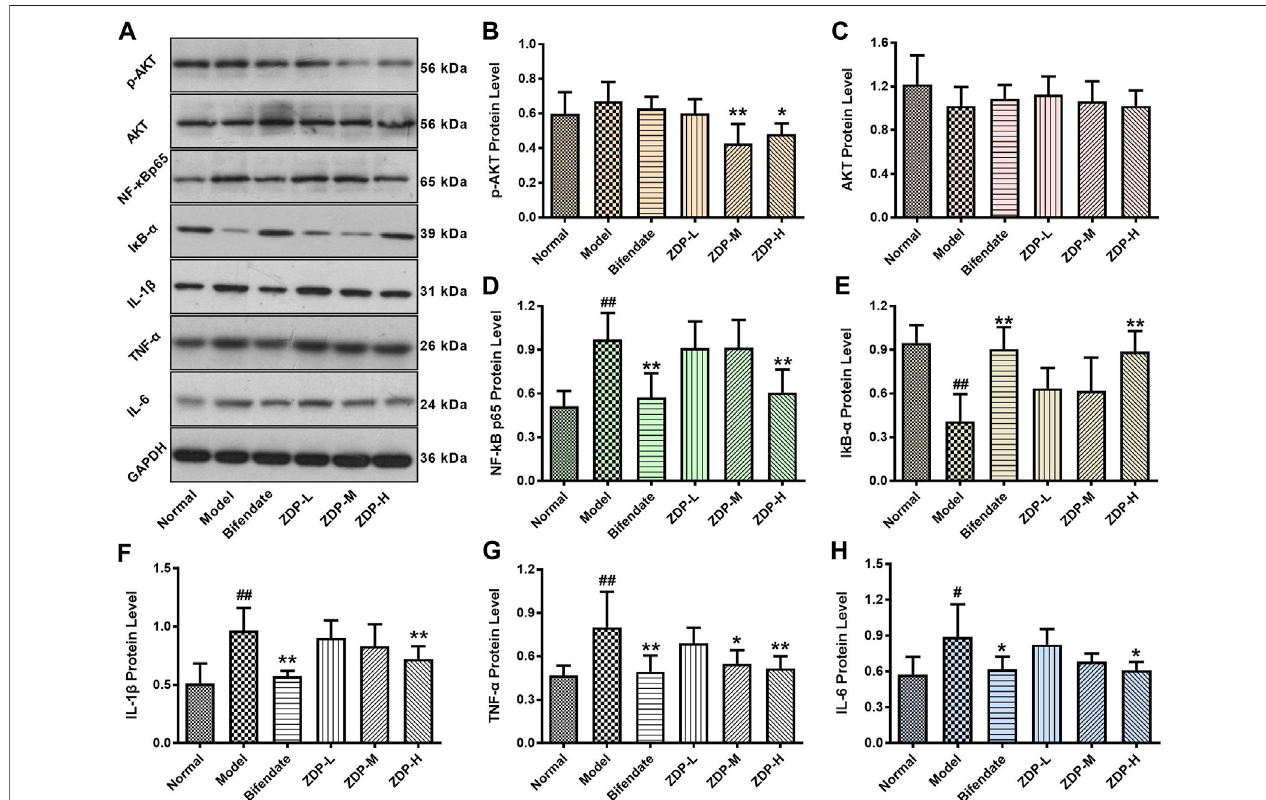
FIGURE7| EffectsofZDPontheproteinexpressionofAkt,p-Akt,NF- κ Bp65,I κ B- α ,IL-1 β ,TNF- α andIL-6inhepatictissuesofthemurinemodelofALIinducedby CCl 4 . (A) Equal protein quantities in lysates from the liver tissues of mice (Normal control, Model control, Bifendate-treated control, ZDP-L, ZDP-M and ZDP-H) were subjected to western blot with antibodies against Akt, p-Akt, NF- κ B p65, I κ B- α , IL-1 β , TNF- α , IL-6 and GAPDH. p-Akt (B) , Akt (C) , NF- κ B p65 (D) , I κ B- α (E) , IL-1 β (F) , TNF- α (G) andIL-6 (H) proteinintensitieswerequanti fi edbydensitometry,andnormalizedtorespectiveGAPDHlevels.Datafromsixmicepergroupareexpressed as the mean ± SD. Statistical analysis: # p < 0.05, ## p < 0.01 compared with the normal group; * p < 0.05, ** p < 0.01 compared with the model group, One-Way ANOVA.